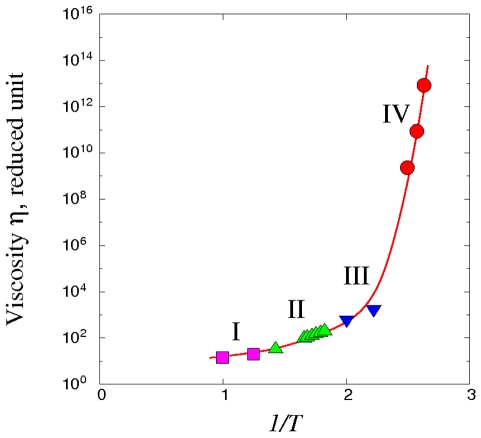
Viscosity computed using the Network model expression, Eq. (16), with the four TSP trajectories shown in
Fig. 2
 as input.Results for each trajectory are denoted by a different symbol, squares for trajectory I, triangle for II, inverted triangles for III, and circles for trajectory IV. Solid curve is a spline fit to all the calculated viscosities.